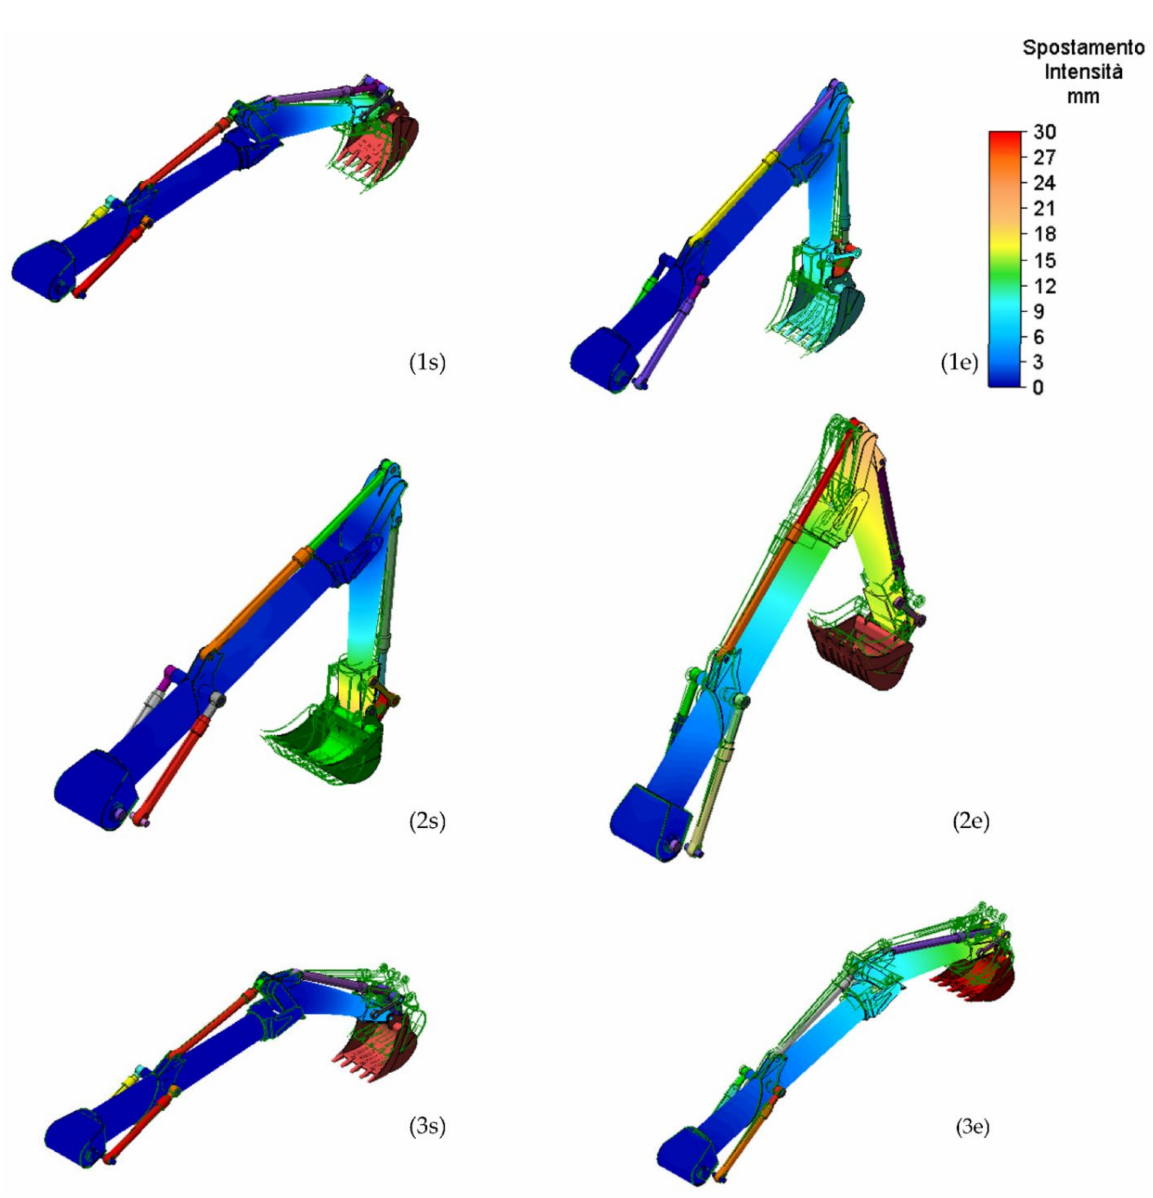
Figure 9. Displacements for the work conditions 1, 2, and 3 for both boom and stick: start ( s ) and end ( e )